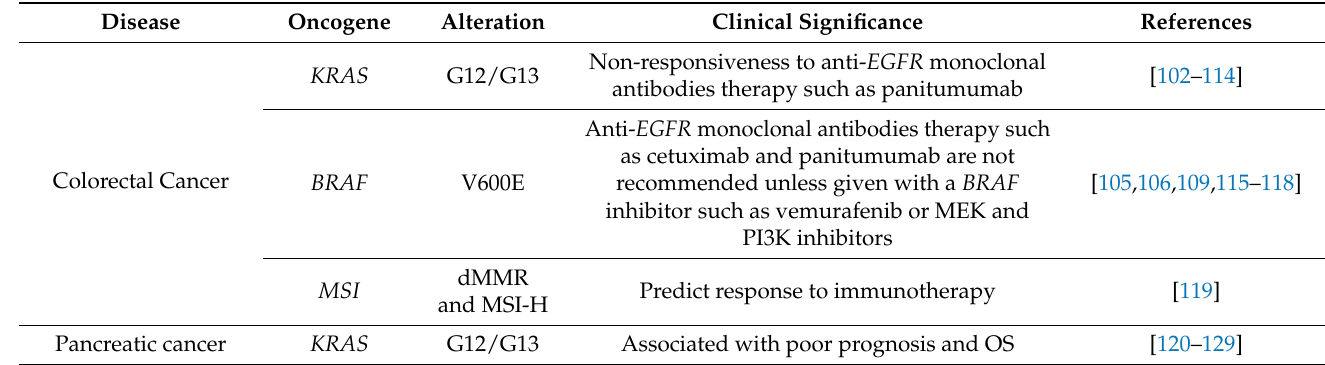
Table 4. The most relevant molecular alterations detected via ctDNA ddPCR assays and their clinical significance in CRC and